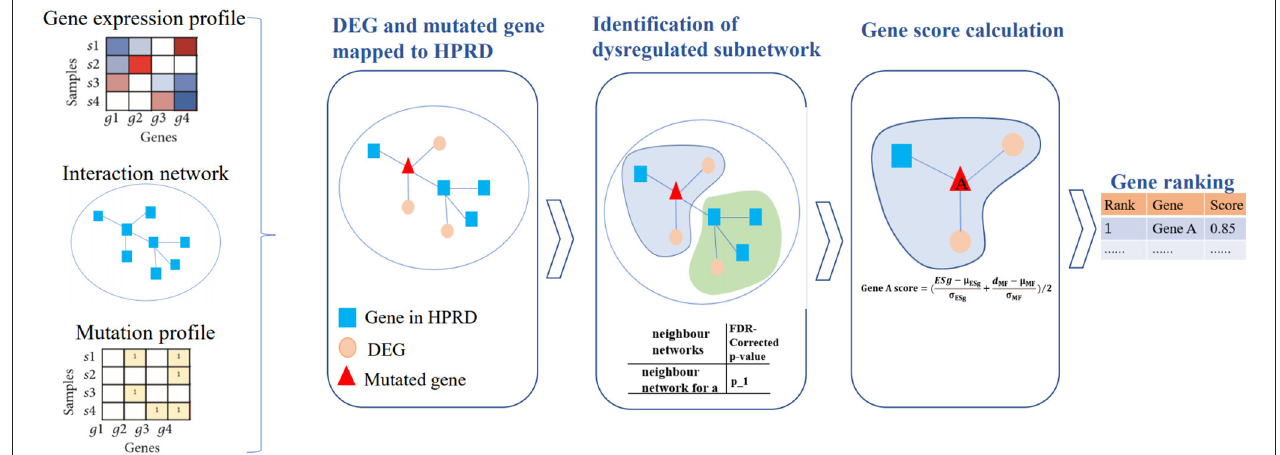
FIGURE 1 | The pipeline of DriverSubNet. Differential expression analysis was performed using the DESeq2 package. All genes with adjusted p < 0.05 were considered as DEGs. DEGs and mutated genes were mapped to the network. We extract a neighbor subnetwork from the protein interaction network for each mutated gene, where a gene and its neighbor genes together consisted of an adjacent neighbor subnetwork. We then evaluate whether the subnetwork is deregulated subnetwork by enrichment analysis. An enrichment score ESg was obtained by evaluating the functional significance of the central gene in each neighbor subnetwork. Each center gene with an enrichment score ESg was calculated. Finally, candidate genes were ranked according to their overall mutational influence scores and ESg